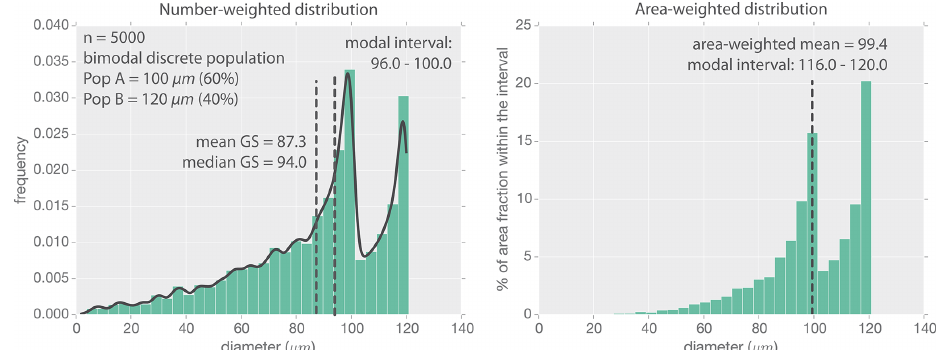
Figure 5. Grain size distribution plots of a bimodal discrete population consisting of a 60/40% mixture of spherical particles with sizes 100 and 120 respectively. The contribution in volume is 46.5/53.5% respectively. The two local maxima in both plots indicate the existence of two populations of spheres with sizes specified by the local maxima. Both plots show different modal intervals due to the different approaches (see Sect. 2.2). The area-weighted plot locates the modal interval in the population that represents the major/main phase (i.e. the volumetric